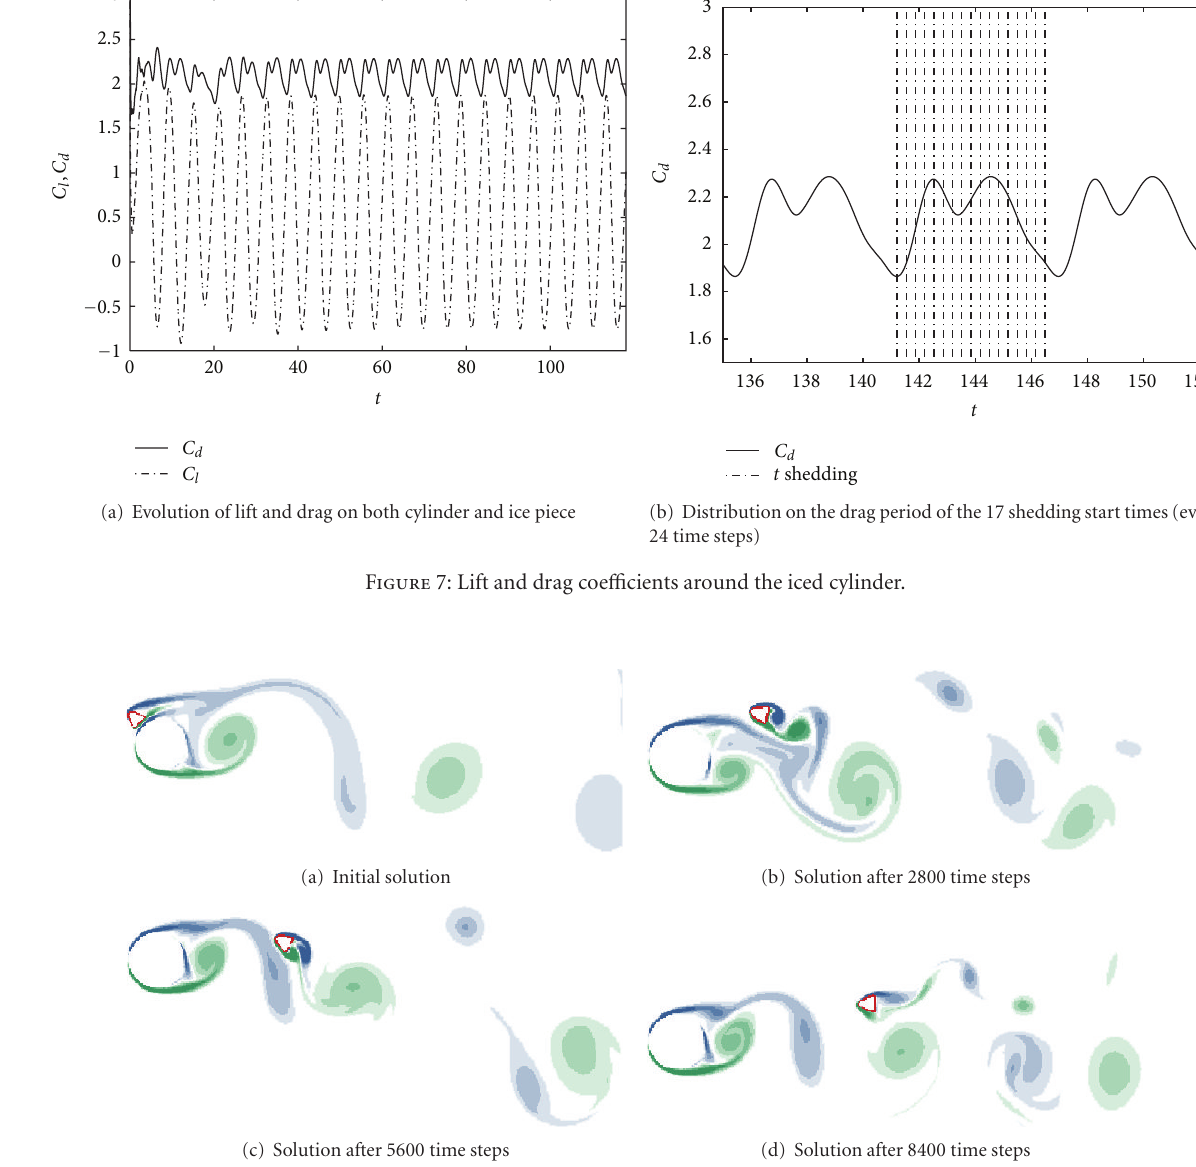
Figure 8: Cylinder at Re = 550. Vorticity contours corresponding to shed 13: green positive vorticity and blue negative